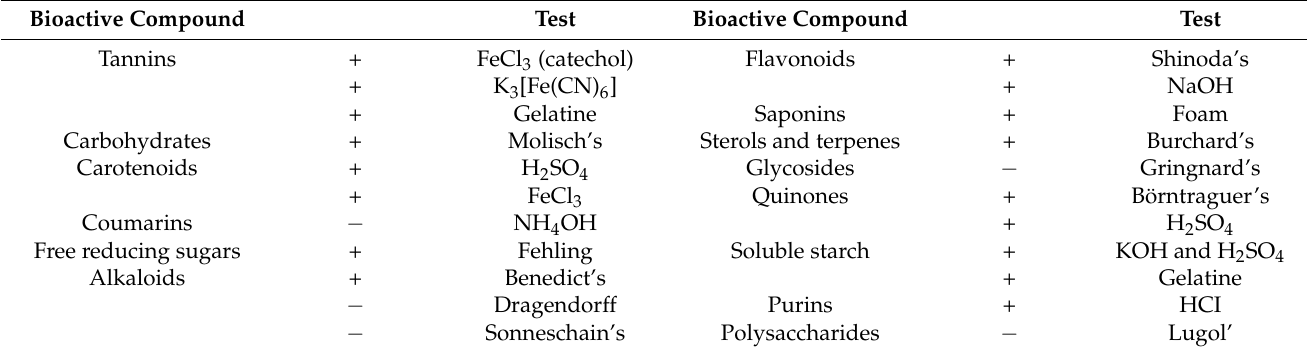
Table 1. Secondary metabolites (“+” = present; “ − ” = absent) in Magnolia tamaulipana leaf ethanolic powdered